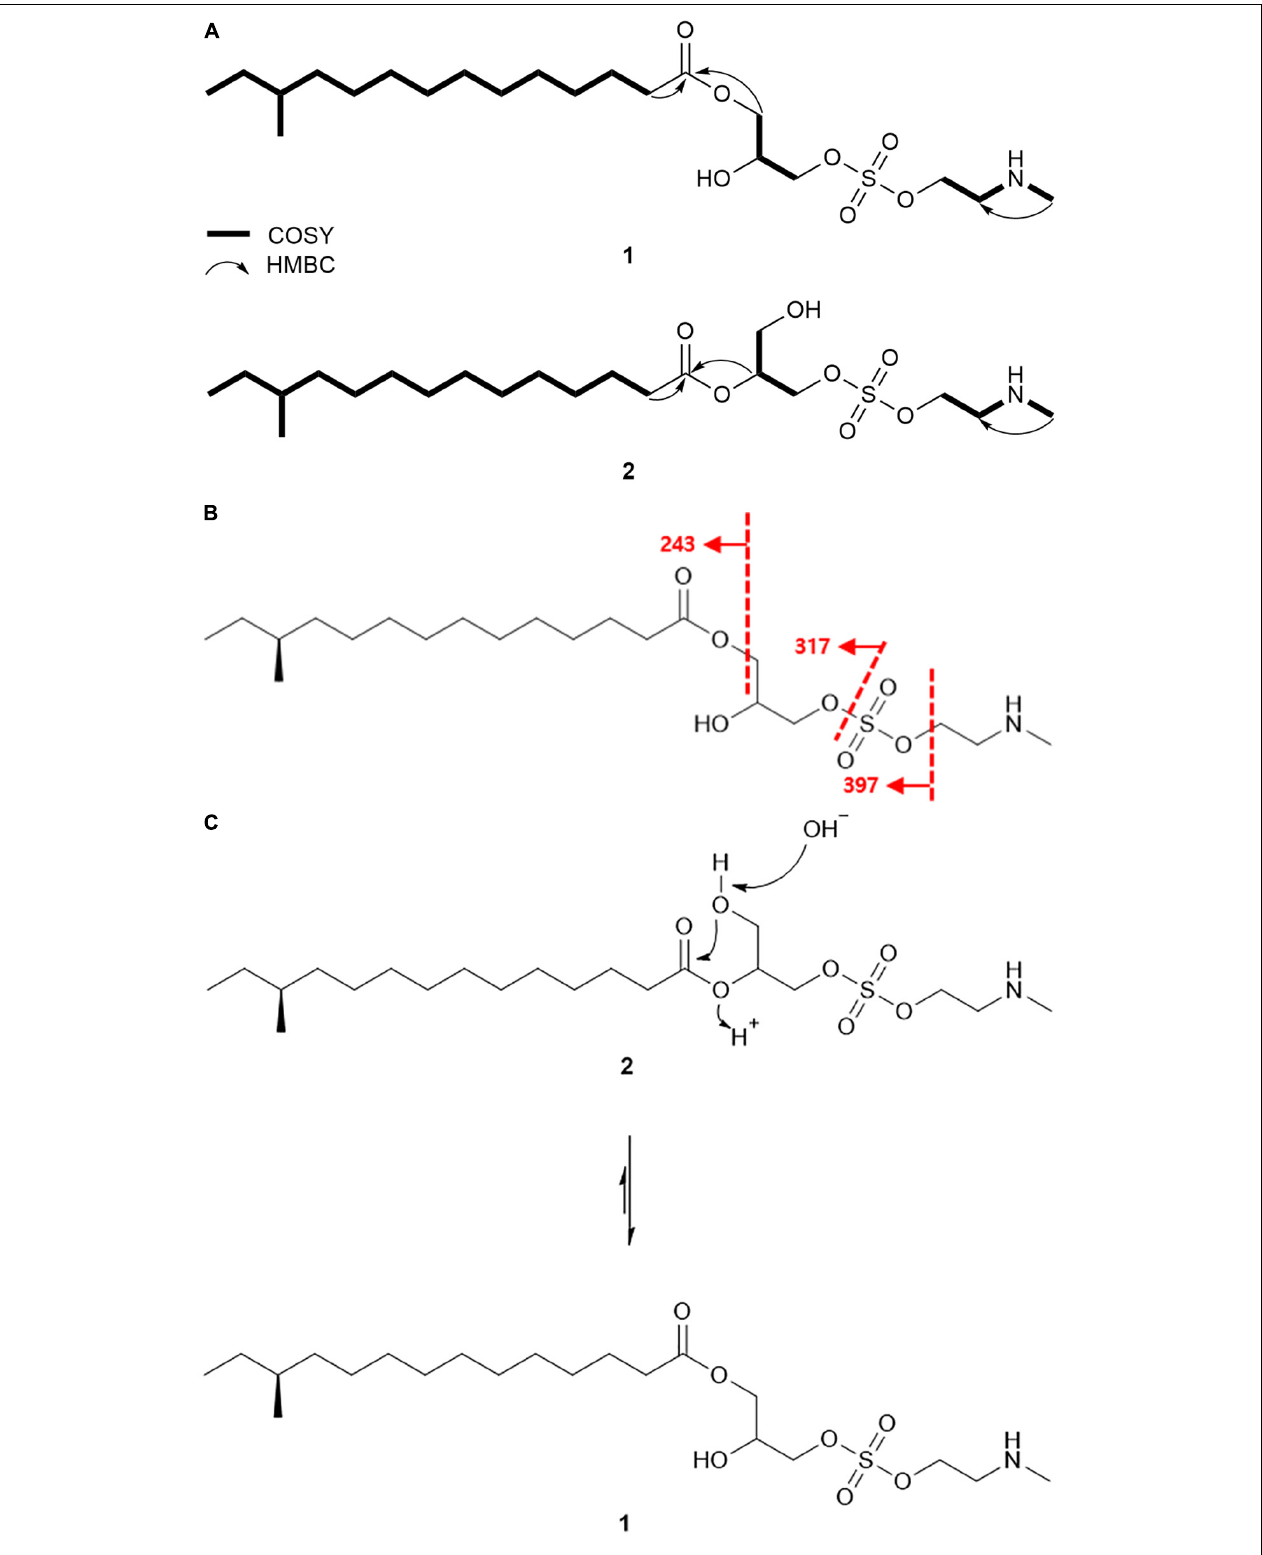
FIGURE 3 | Detailed analysis of planar structures of lenzimycins. (A) Key 1 H- 1 H COSY and HMBC correlations of lenzimycins A and B ( 1 - 2 ). (B) ESI-HR-MS/MS fragmentation of lenzimycin A ( 1 ). (C) Rearrangement between lenzimycins A and B ( 1 - 2 ).